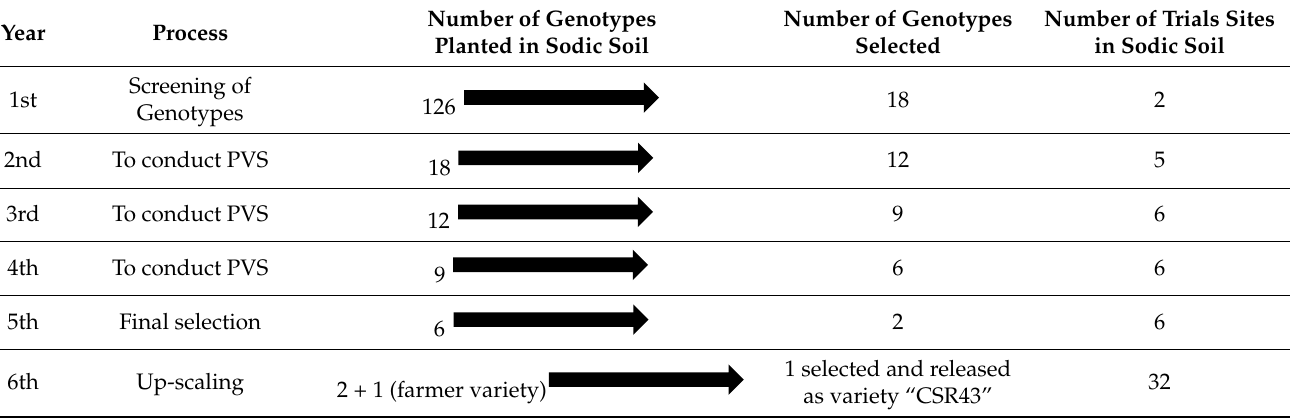
Table 2. FPVS process for developing salt tolerant variety. The arrow sign is indicating that out of three outstanding performing genotypes only one is selected to develop as a variety. Number of Genotypes Number of Geno- Number of Trials Process Planted in Sodic Soil types Selected